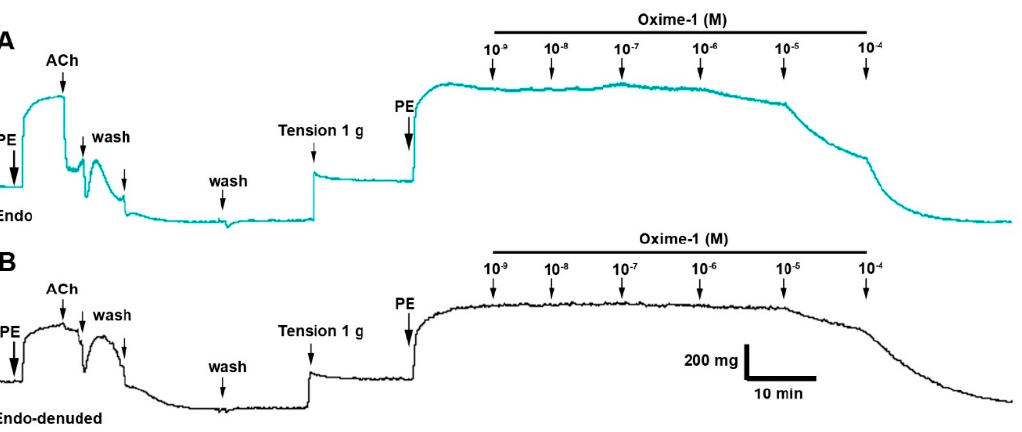
Figure 3. Oxime–1 causes relaxation in rat aorta via the endothelium-dependent pathway. Aortic rings were pre-contracted with 10 − 6 M phenylephrine (PE), and cumulative concentrations of oxime–1 (10 − 9 to 10 − 4 M) were added in bath. Representative trace showing of vascular effect in intact aortic ring (Endo) ( A ) and endothelium-denuded (Endo-denuded) aortic ring ( B ).